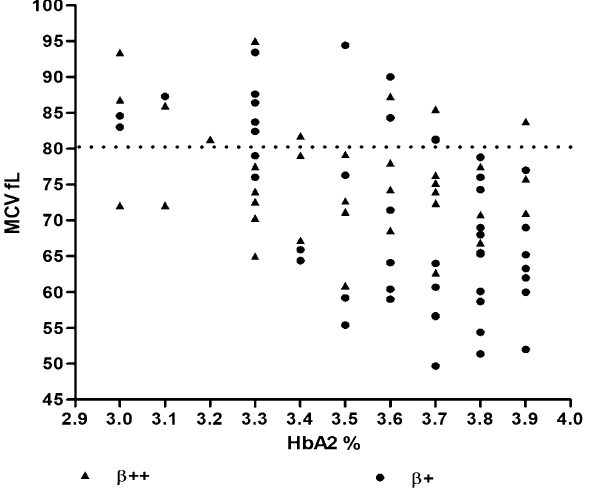
Figure 3. Distribution of the MCV and HbA 2 levels of the two most common genotypes in borderline HbA 2 individuals with MCV < and > 80